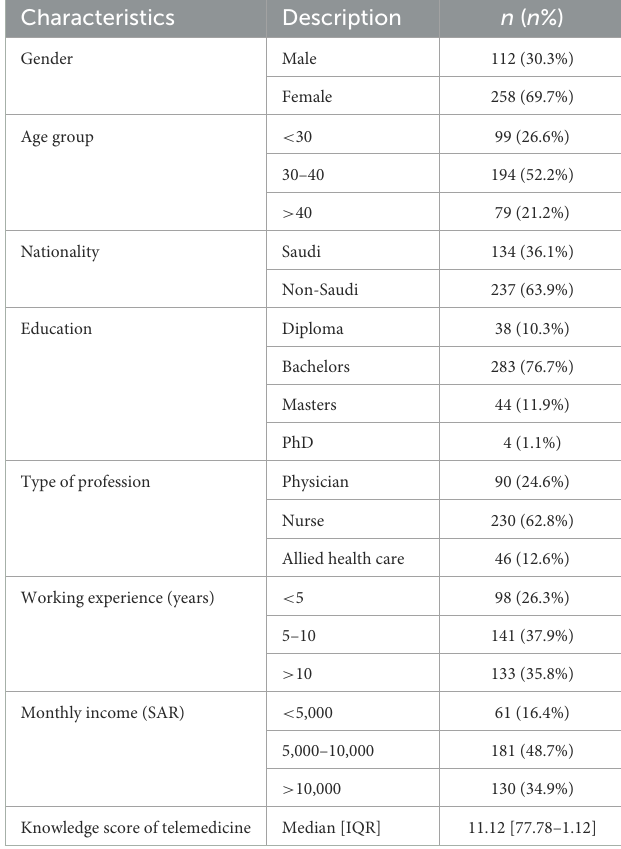
TABLE 1 Basic demographic characteristics of participants ( n =